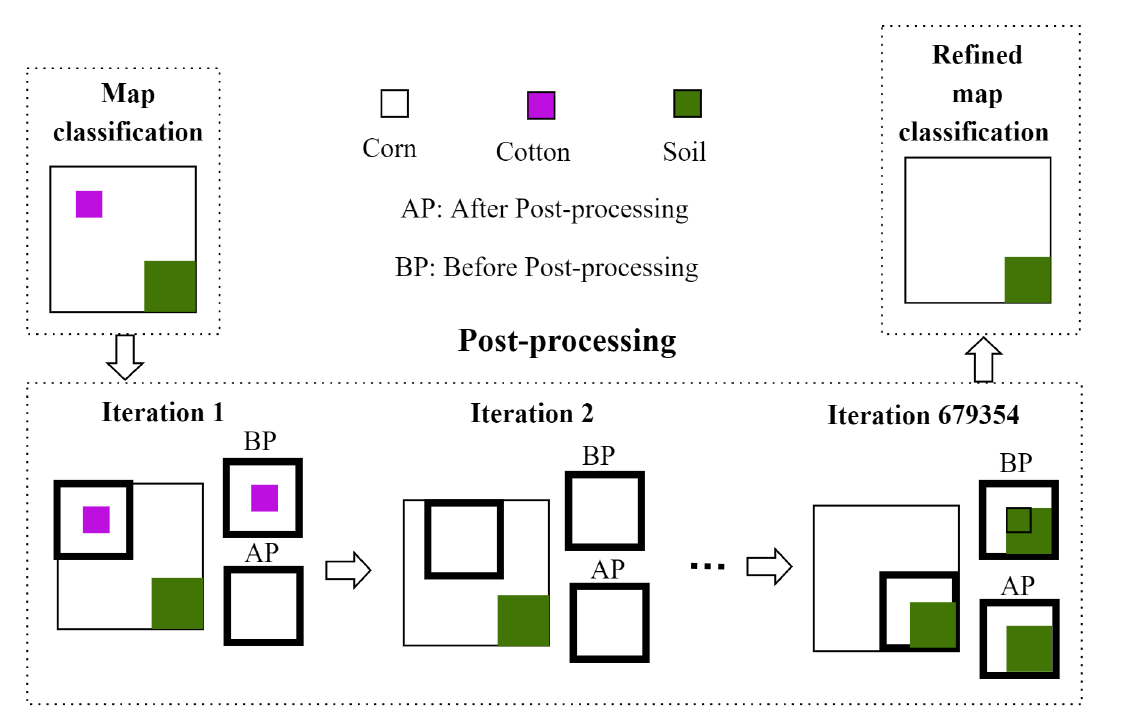
Figure 7. Example of the post-processing technique based on consecutive morphological operations.